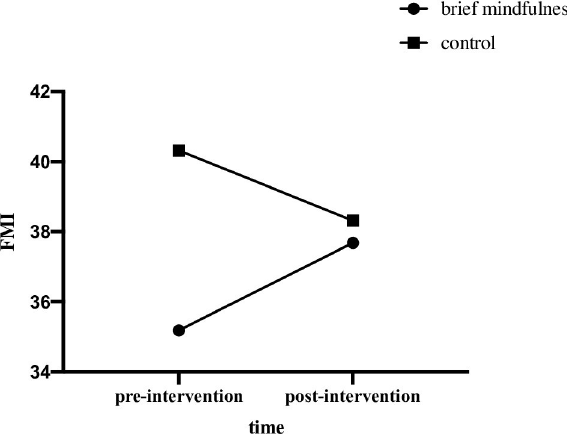
Fig 1. FMI scores of two groups in pre- and post-